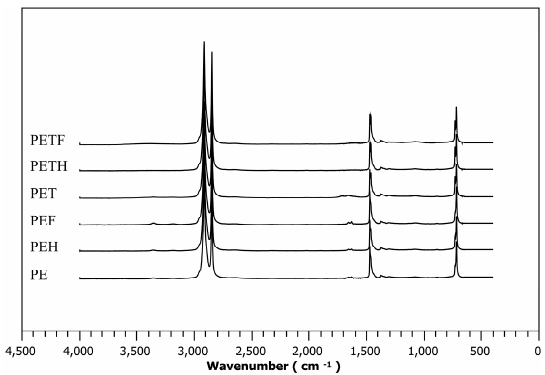
Figure 4. Attenuated total reflectance Fourier transform infrared ATR-FTIR spectra.